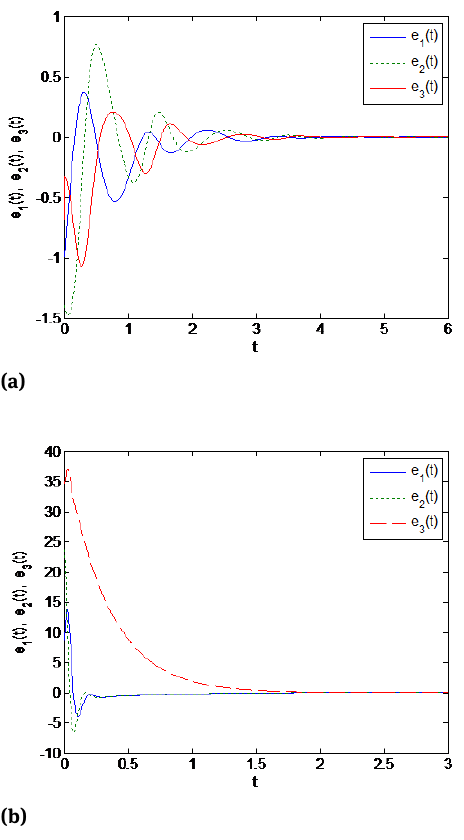
sponse system are considered. The time step size is taken as 0.005. The synchronization among four fractional order chaotic systems are achieved through Fig. 3 using the same method at q = 0.95. Figs. 3(a), 3(b) and 3(c) show the time response of the states x ( t ) + y ( t ) + ( t ) and w ( t ), where i i i i i = 1, 2, 3 represent the drive systems (5), (6), (7) and the response system (8). The error states for this case are de- scribed through Fig. 3(d). It is noticed that it takes less time for synchronization among four systems (Fig. 3(d)) com- pared to that of three systems (Fig. 2(d)) for the considered systems in both fractional order as well as integer order case (Fig.